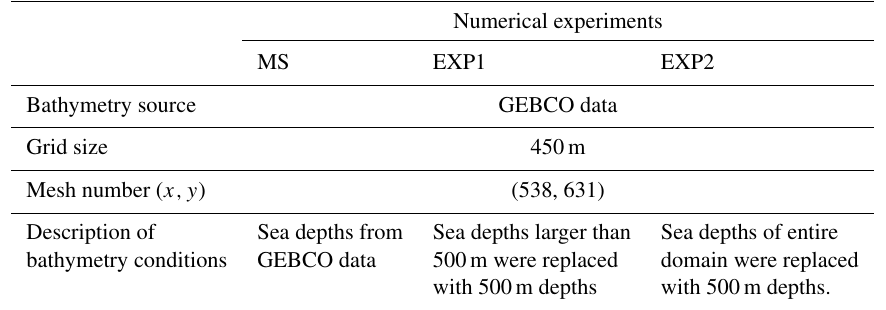
Table 5. Details of the bathymetry data used for the numerical experiments MS, EXP1, and